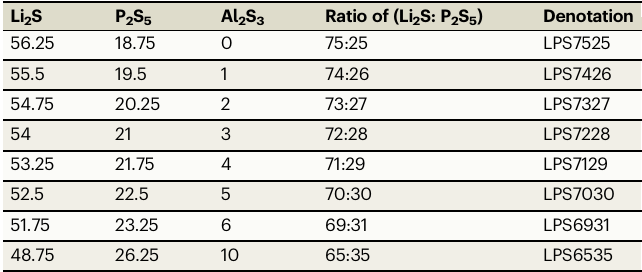
Table 1 | Molar ratio of the reagents (Li 2 S, P 2 S 5 , Al 2 S 3 ) in Al- GCs and the corresponding